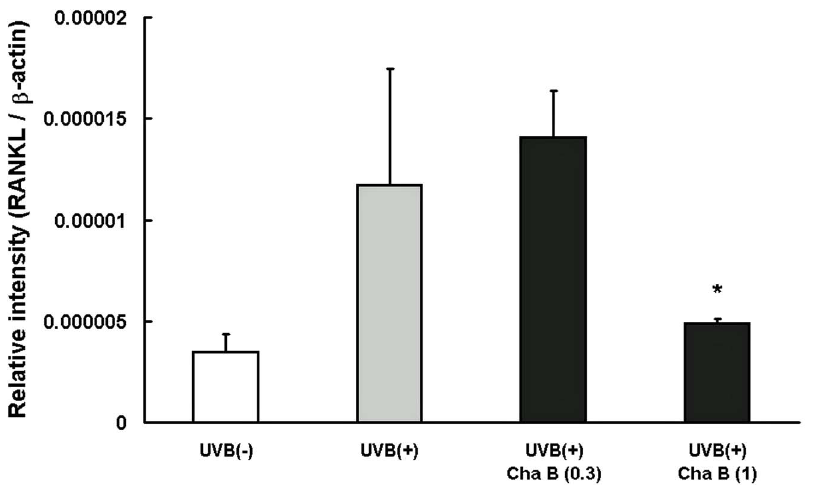
Figure 4. Chafuroside B decreased the mRNA expression of RANKL induced by UVB radiation in human keratinocytes. NHEK were irradiated with UVB (20 mJ/cm 2 ), and then treated with chafuroside B (0.3 and 1 m M). The cells were harvested after 24 h and RANKL mRNA was evaluated by means of RT-PCR. Cha B = Chafuroside B. All data are expressed as the mean 6 SD ( n =3 or 4). * P , 0.05 compared with UVB ( + ).